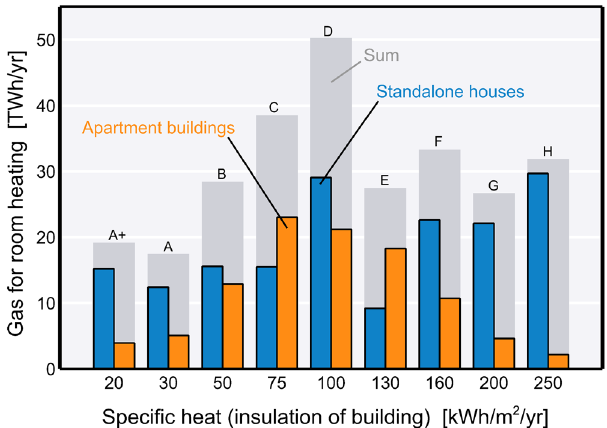
Fig. 1 The gas for domestic space heating used in Germany. Amounts are per year, in standalone houses and apartment buildings, respectively, distinguished in energy ef fi ciency classes (building insulation) from A to H 31 , expressed as speci fi c heating energy, from a compilation of data 30 . Data are listed in Supplementary Table S3.